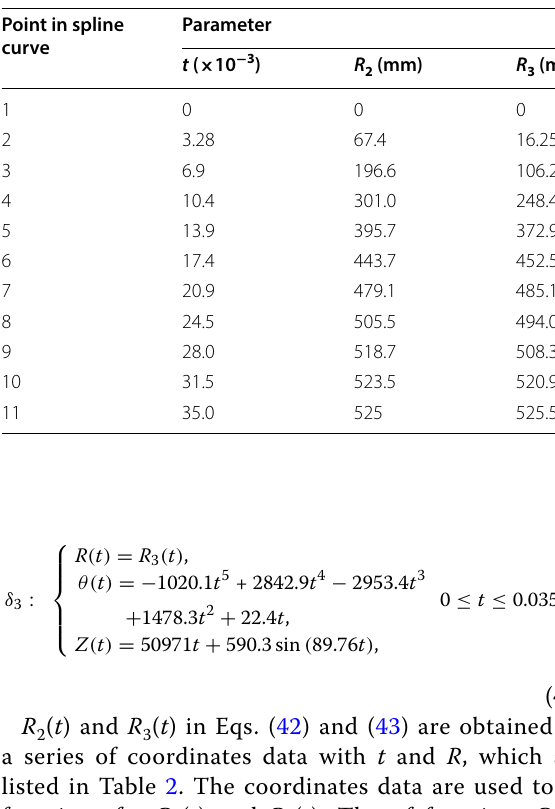
( t ) and R ( t ) function 2 3